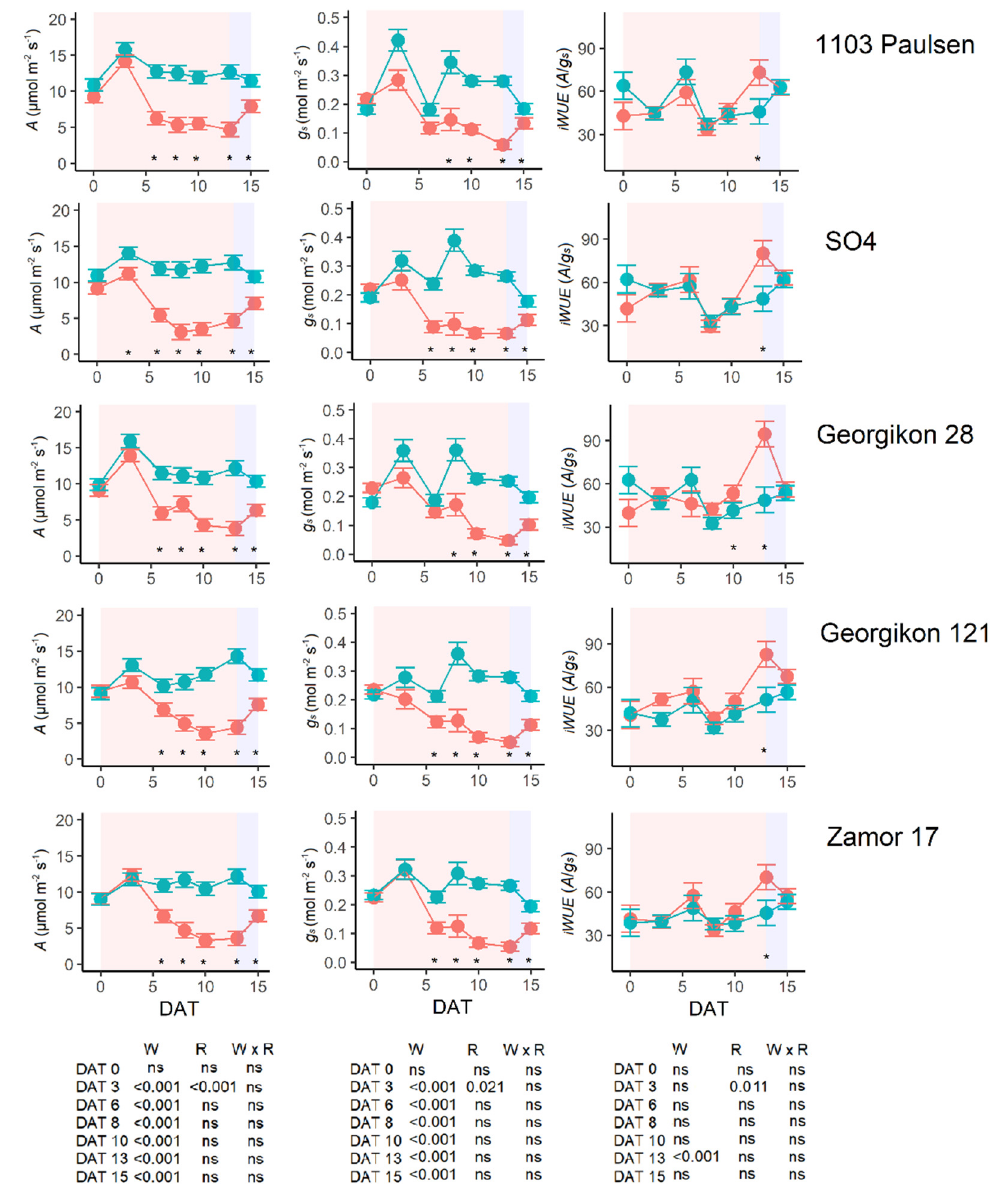
Figure 7. In vivo assessment of daily changes in CO 2 assimilation rate ( A ), stomatal conductance ( g s ) and intrinsic water-use efficiency ( i WUE ) of Pinot gris grafted on five rootstocks and subjected to well-watered (WW, blue dots) and water stress (WS, red dots) conditions. Red background represents the length of stress application, blue background recovery. Two-way ANOVA p -values are shown in the graphs for both A and g s and for each DAT. Asterisks denote significant differences according to one-way ANOVA between WW and WS for each trait and rootstock. Data shown are means ± standard error of the means (SEM, n = 4–5).